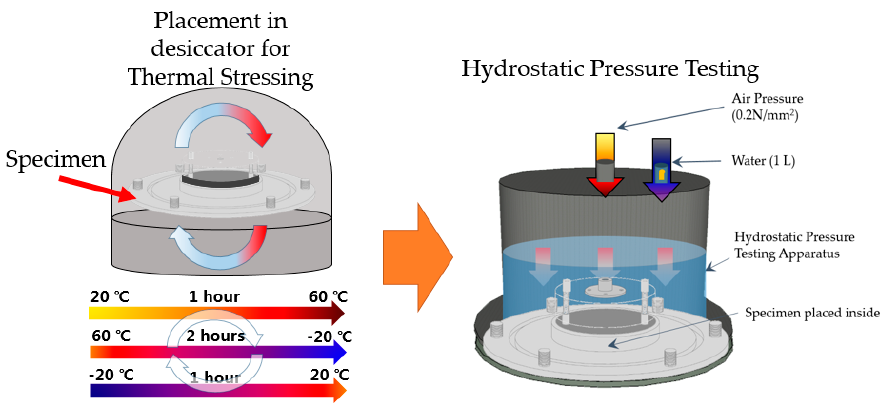
Figure 7. The test method outline and apparatus.